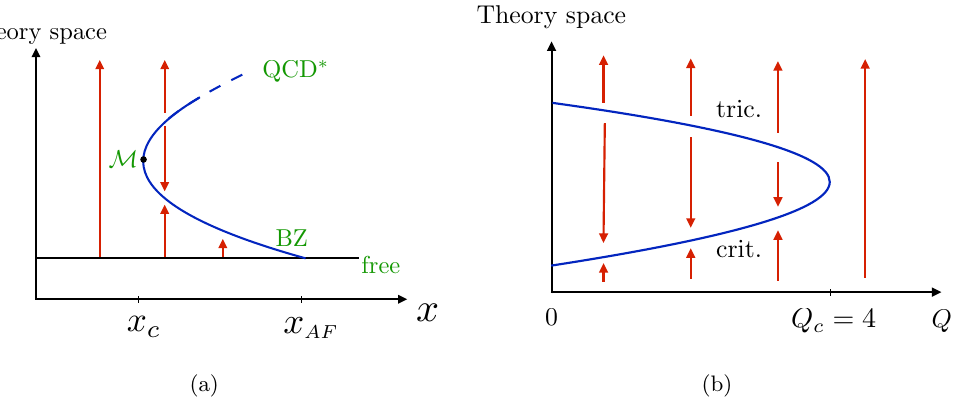
Figure 4 . Left: schematic view of the space of existing (cid:12)xed points of 4d gauge theories as a function of x = N f =N c . The trivial (cid:12)xed point (free) exists for any x . The line of BZ (cid:12)xed points branches o(cid:11) from the free theory line at x = x AF . At some smaller x = x c it annihilates with the line of QCD (cid:3) (cid:12)xed points. This latter line should exist for x close to x c but it’s not a priori clear where it starts. Right: schematic view of the space of (cid:12)xed points for the 2d Potts model. No theory merges with the free theory, at least in the range Q > 0 we are interested